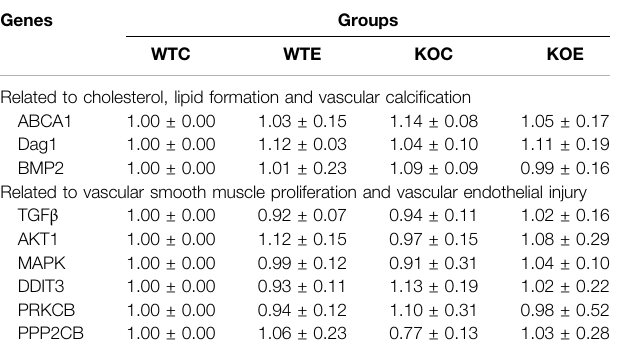
TABLE3| Relativeexpressionofgenerelatedtovascularinjury*(Mean ± standard deviation). Genes Groups WTC WTE KOC KOE Related to cholesterol, lipid formation and vascular calci fi cation